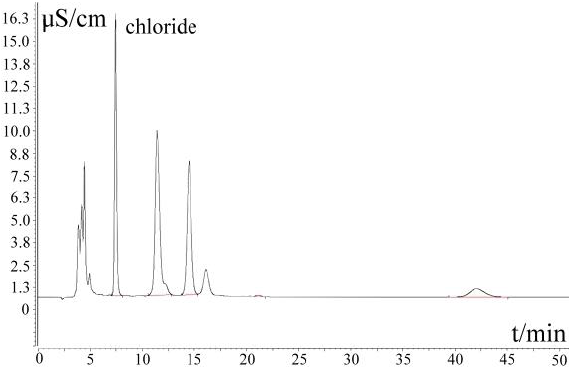
Figure 6. Ion chromatographic analysis of